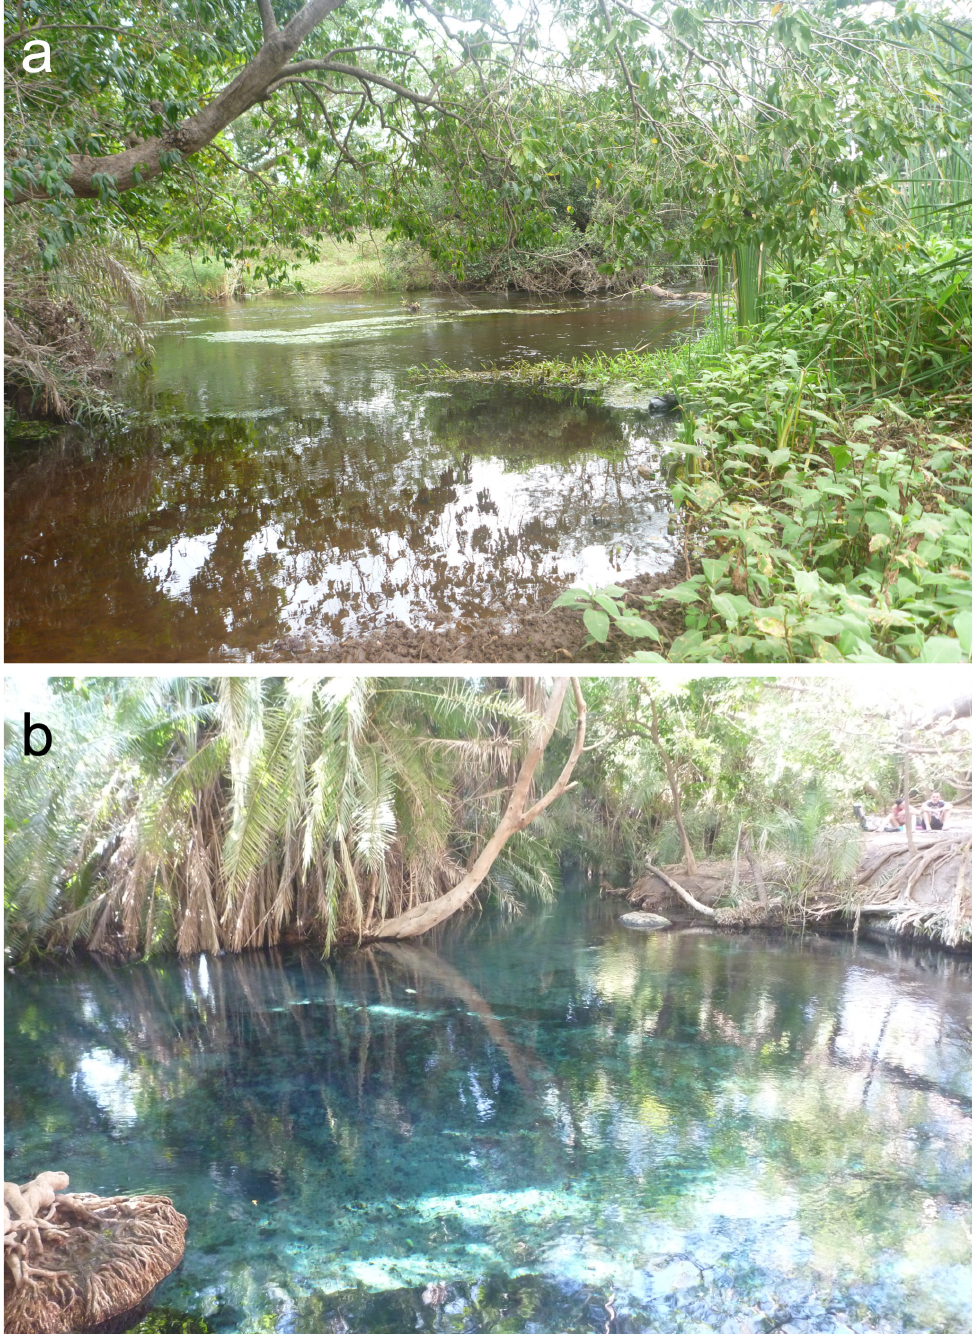
Fig. 2. a . Ruvu River where specimens of Ctenochromis pectoralis Pfeffer, 1893 were collected. b . Chemka Springs where specimens of C. scatebra Genner, Ngatunga & Turner sp. nov. were collected. See Table 1 for collection